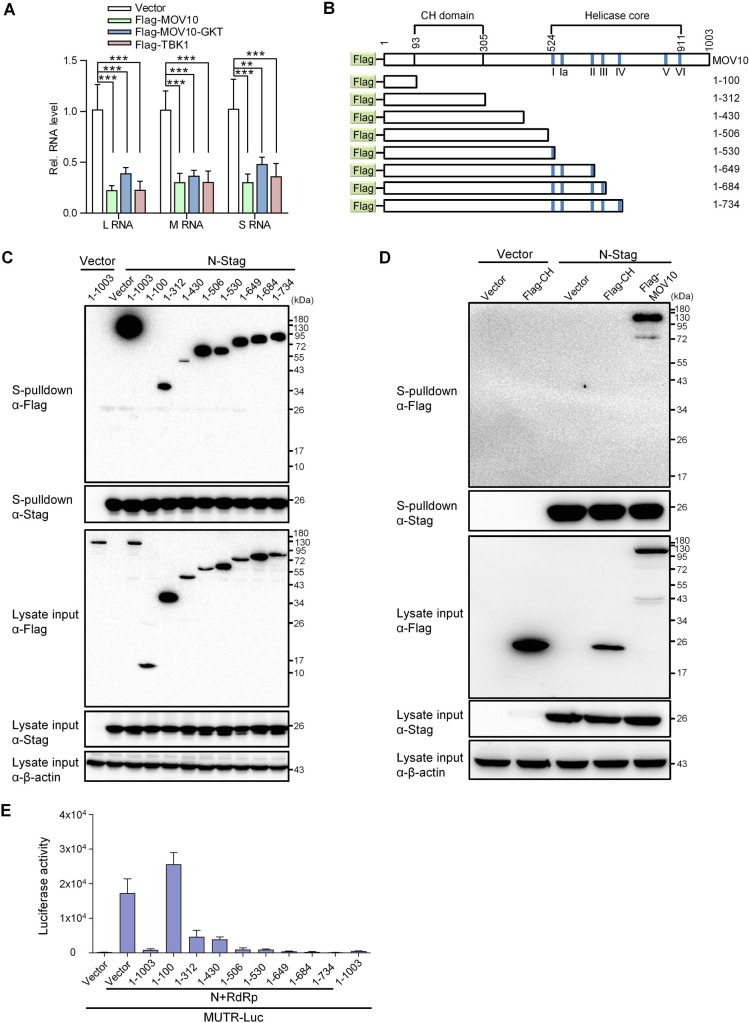
The N terminal domain (but not helicase region) of MOV10 is required for its targeting of N and inhibition of RNP.(A) HEK293T transfected with the control vector or the plasmids expressing Flag-tagged MOV10, MOV10GKT (helicase-inactive mutant with G529A/K530A/T531A substitutions), or TBK1 were infected with SFTSV (0.1 MOI), followed by detection of virus RNA levels at 24 hpi with qPCR. (B) Schematic diagrams showing the organization of Flag-tagged MOV10 and truncated mutants used below. The helicase core contains 7 motifs, i.e., I, Ia, II, III, IV, V, and VI. (C and D) HEK293T cells co-transfected with the plasmids encoding the indicated proteins were subjected to S-pulldown assays, followed by IB detection. (E) Effects of the truncated MOV10 mutants on SFTSV RNP activity were analyzed with the minigenome system as performed in Fig 5A. Data show means ± SD, n = 3. **p < 0.01; ***p < 0.001. See also S7C Fig.